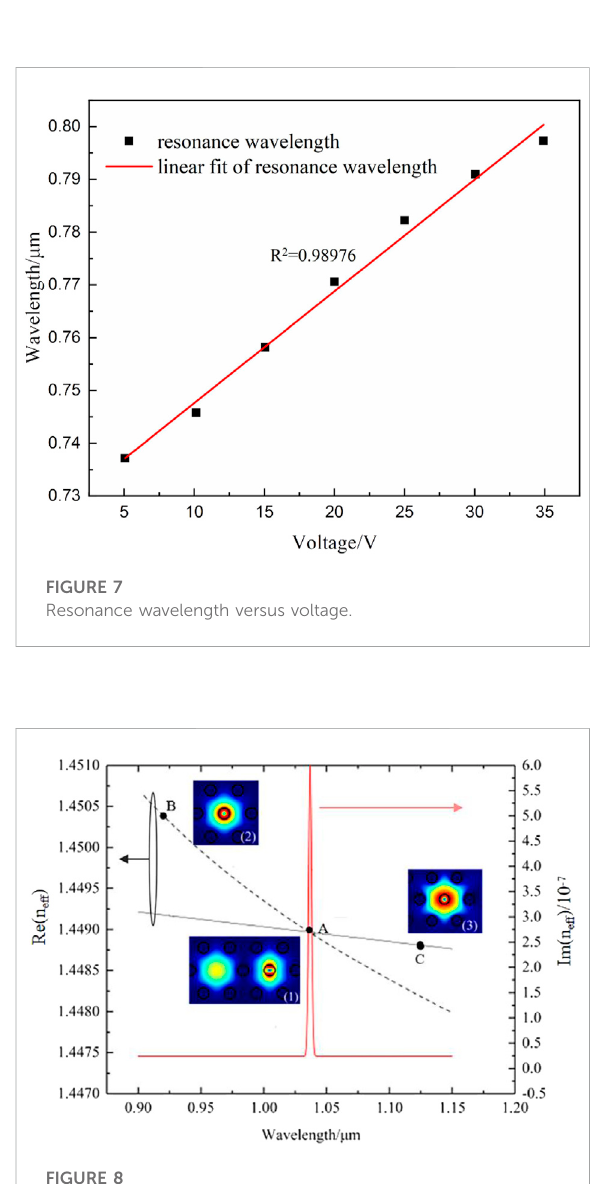
FIGURE 8 Dispersion characteristics (black solid line) and loss characteristics (red solid line) of core mode, as well as the dispersion characteristics (dotted black line) of defect mode in directional coupling channel. [Illustrations (1) is the fi eld distributions of core mode and defect mode at point (A) . Illustration (2) is the fi eld distribution of directional coupled-mode atpoint (B) .Illustrations(3)isthe fi elddistributionsofcoremodeat point (C)